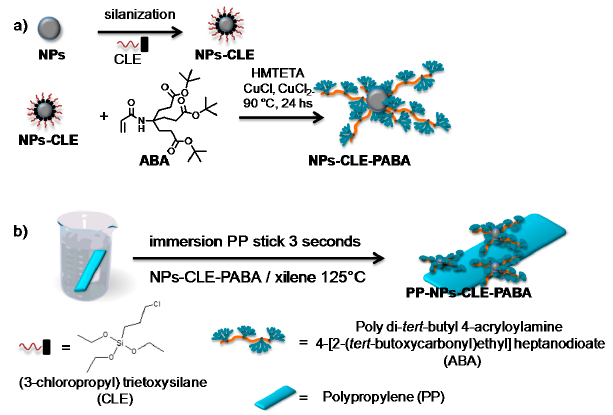
Figure 7. ( a ) TiO 2 NPs functionalization with a dendronized polymer by controlled radical polymerization (ATRP); ( b ) superhydrophobic surfaces of polypropylene (PP) procedure.